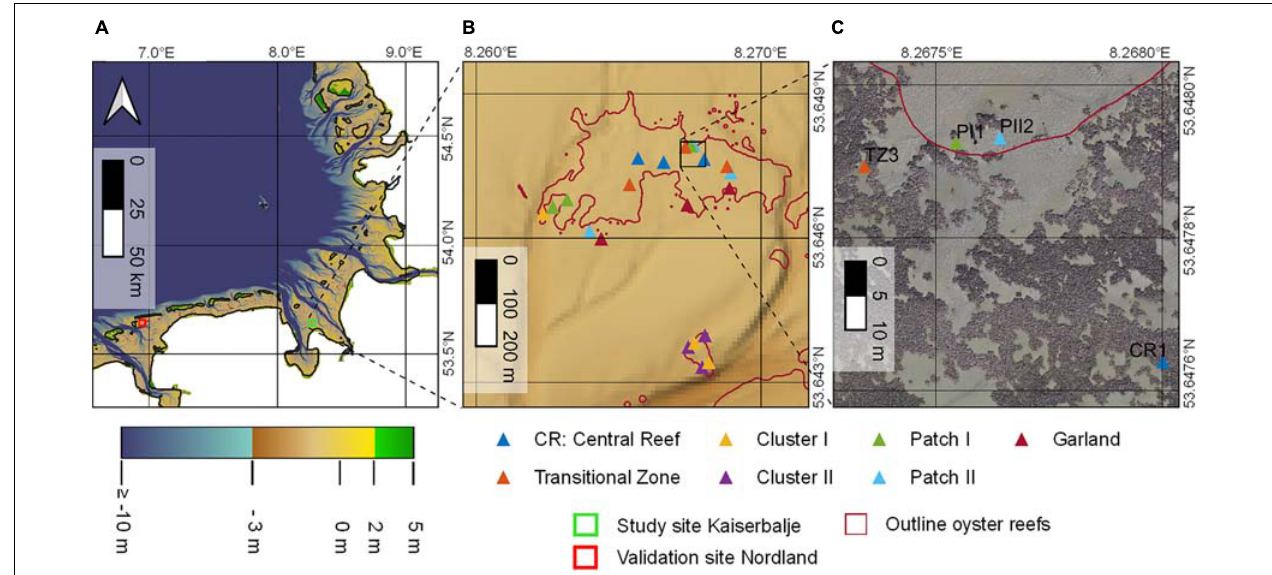
FIGURE 2 | (A) A map showing the bathymetry of the Wadden Sea in the German Bight (Sievers et al., 2020), the study site Kaiserbalje (green square) and the validation site (red square). (B) A map showing the study site oyster reef Kaiserbalje . The reef outlines are marked in magenta (Nationalparkverwaltung Niedersächsisches Wattenmeer, 2021). The triangles illustrate sampling locations with varying colors for each structural class, respectively. (C) An orthomosaic recorded in spring 2020 showing a section of the study site as an example for the complex surface